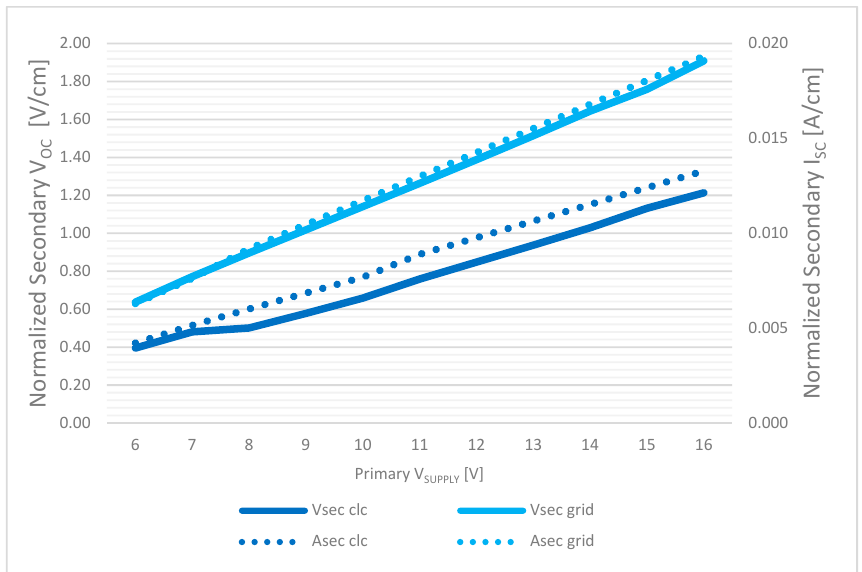
Figure 16. Inductive charging system characterization, normalized secondary V OC and I SC in concrete and reinforced concrete environment.